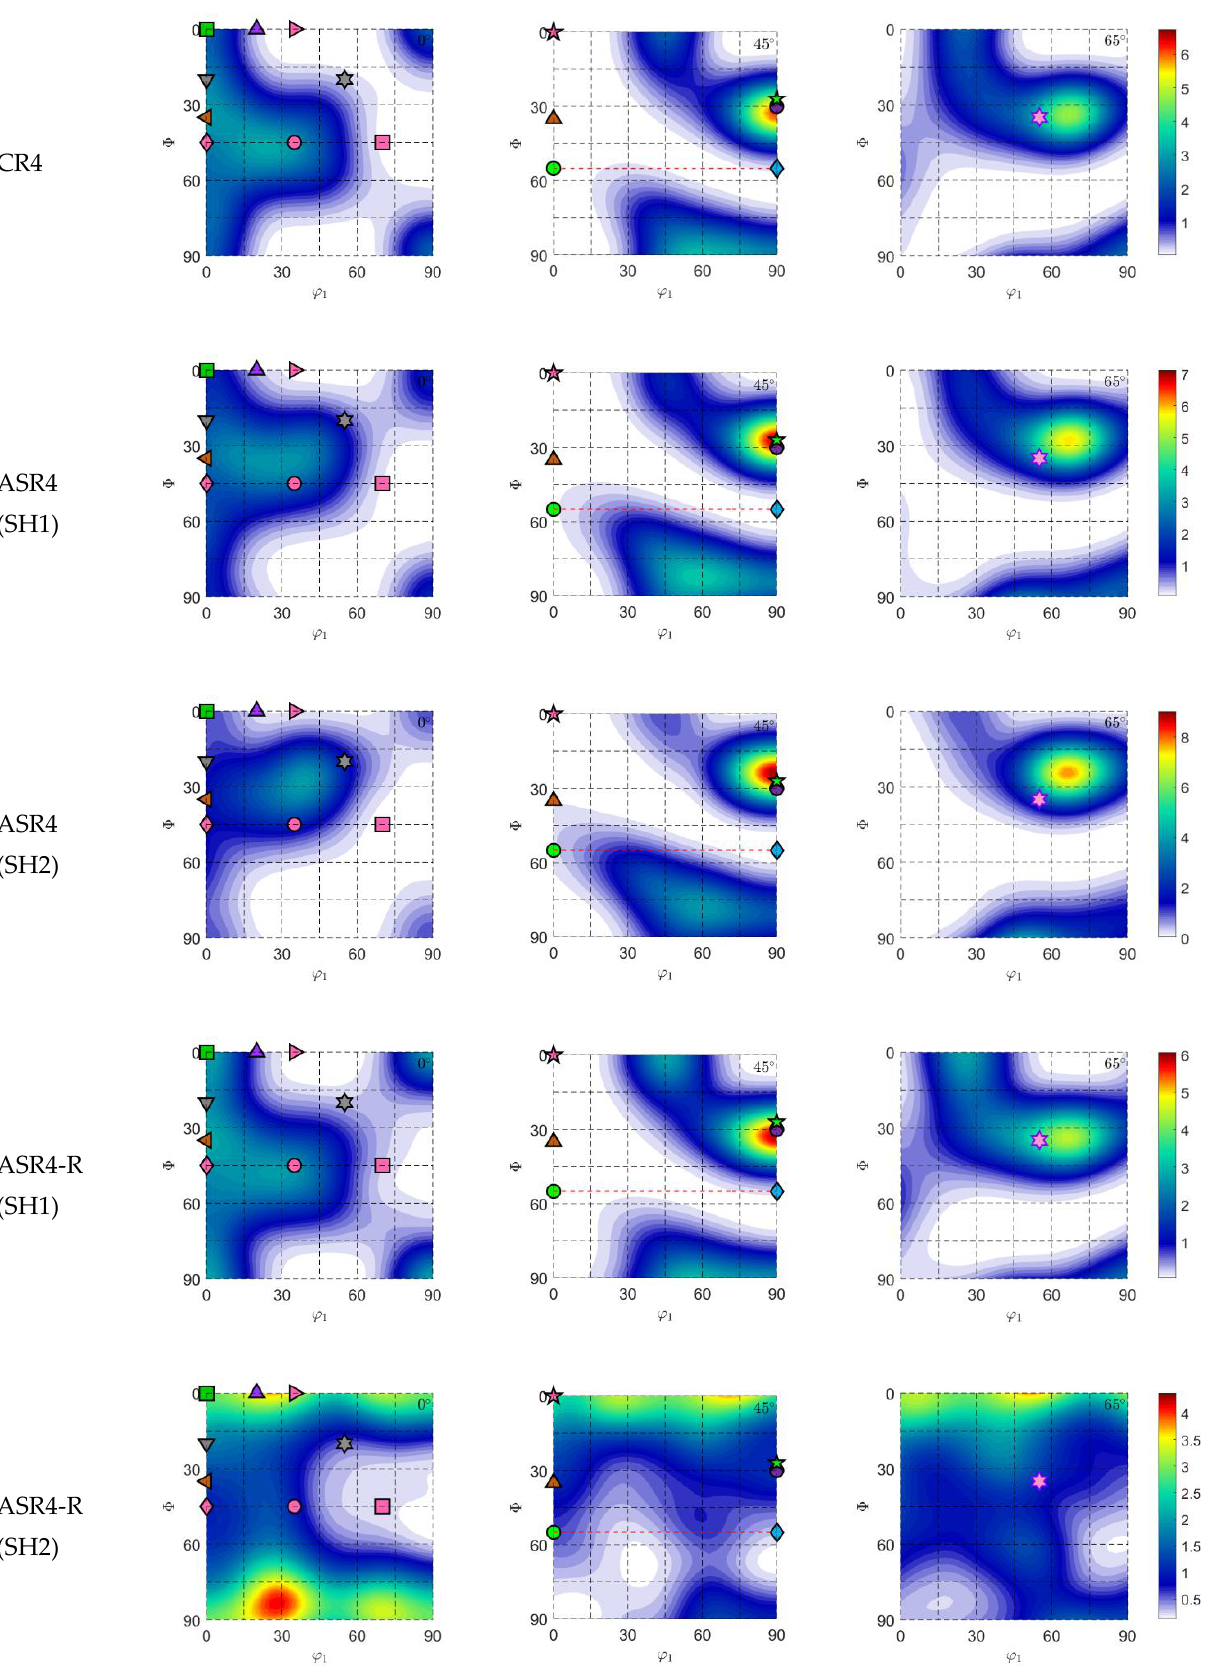
Figure A7. ODF sections for the fourth pass with a 20% thickness reduction per